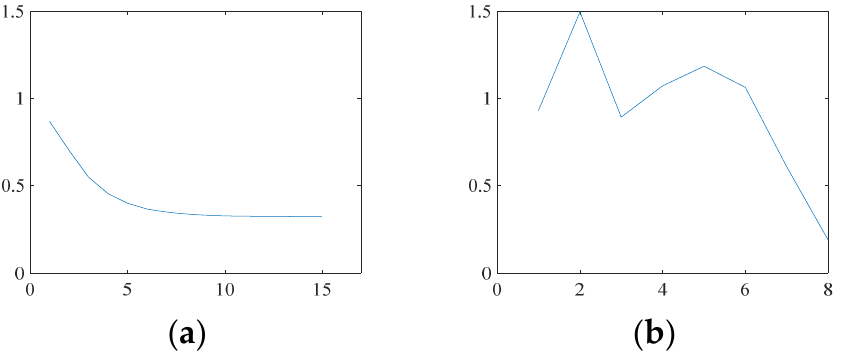
Figure 20. NMSE of ( a ) 2D ‐ ADMM and ( b ) 2D ‐ ADN.